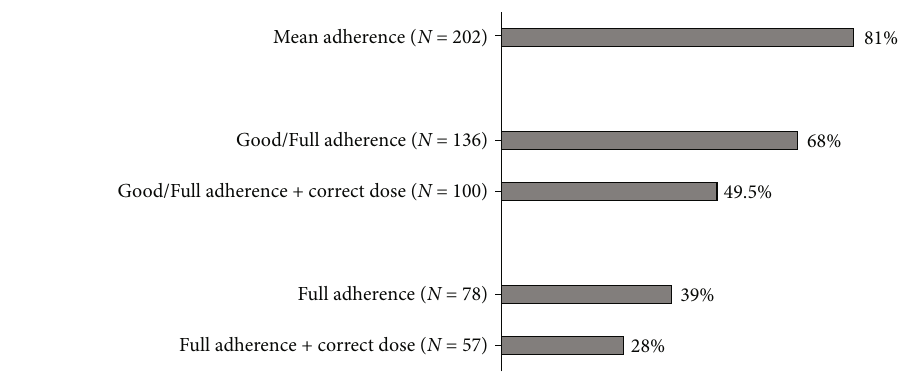
Figure 2: Proportion of patients in each treatment adherence